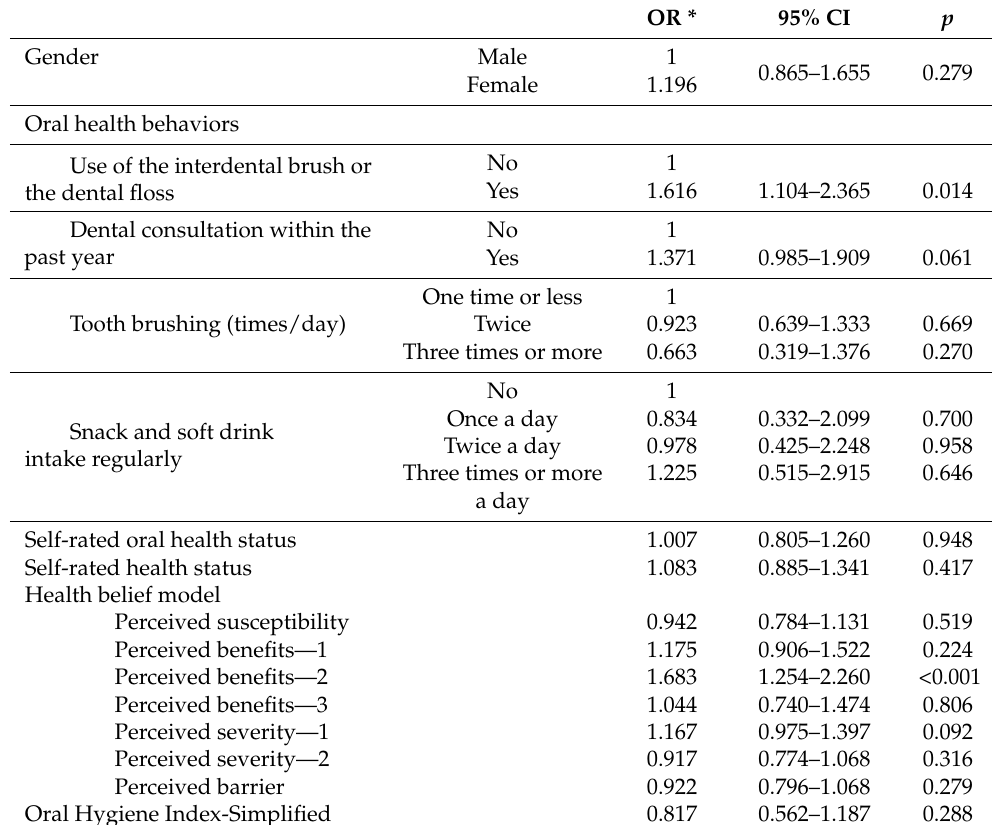
Table 2. Factors associated with willingness to undergo regular dental check-ups (logistic regres- sion